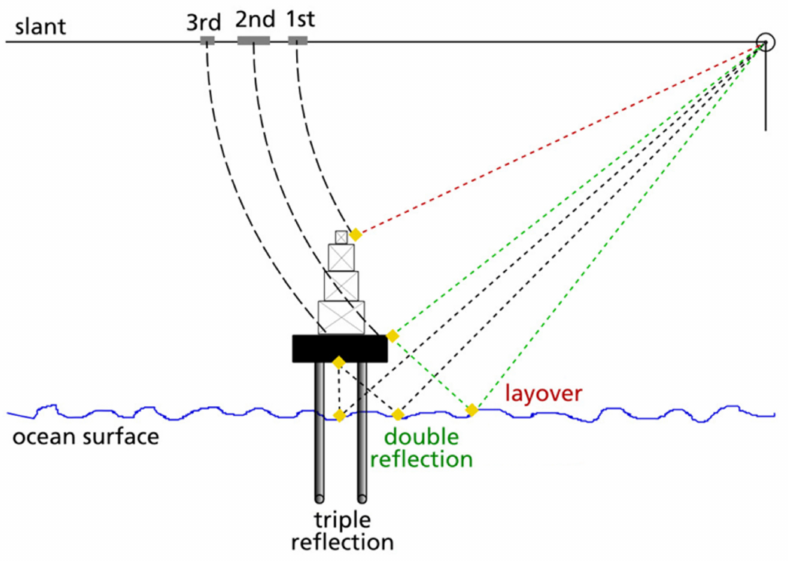
Figure 4. Sketch of the model used to identify the scattering mechanisms for oil